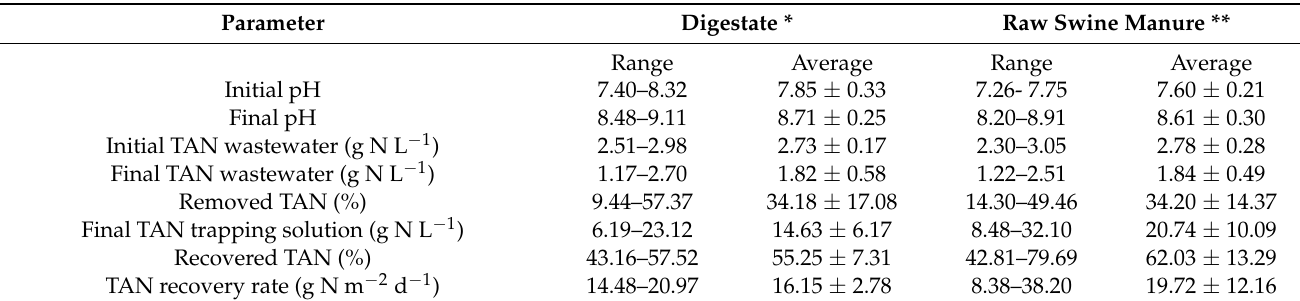
Table 5. Comparison of the results obtained with the GPM pilot plant during the treatment of digestate with the results obtained using the same pilot plant during the treatment of raw swine